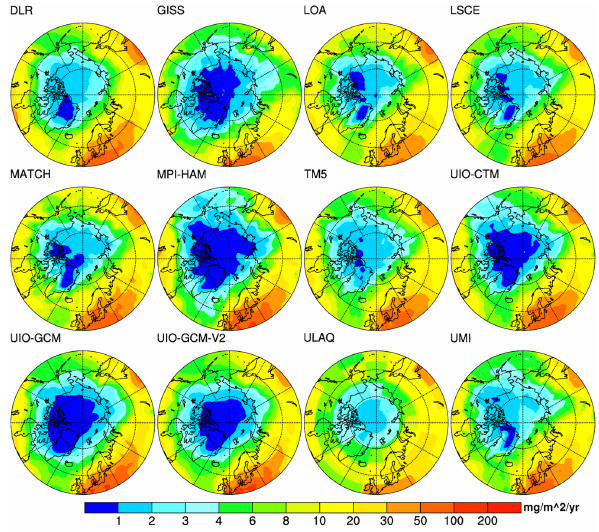
Fig. 7. Annual mean black carbon deposition fluxes for phase I models, plotted from 50 ◦ N to 90 ◦